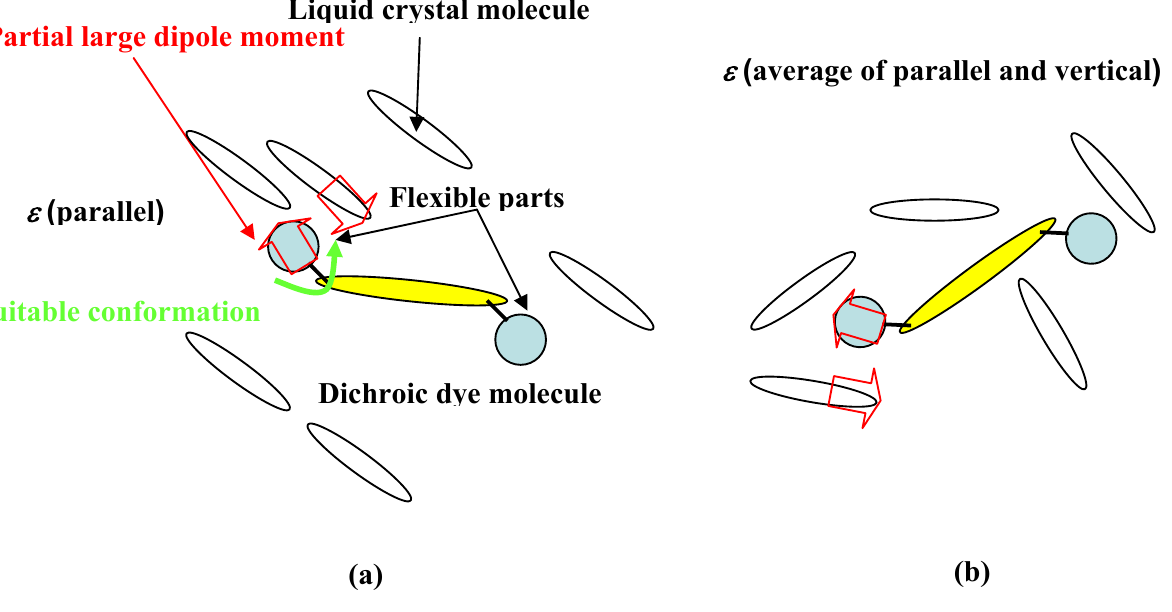
Figure 17. The model of structures of solvation. (a) in liquid crystal phase. (b) in isotropic